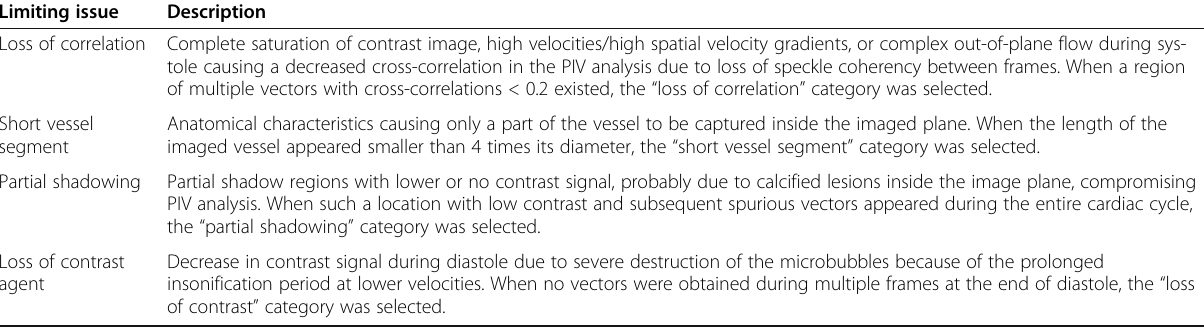
Table 1 Issues limiting optimal flow